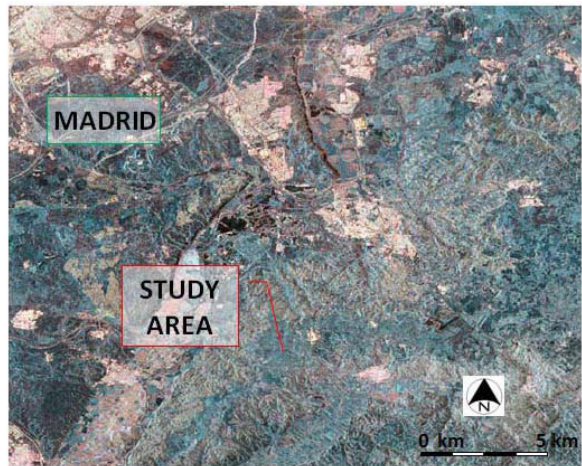
Figure 3. RADARSAT 2 image, PAULI combination (B- SS − R- VVHH